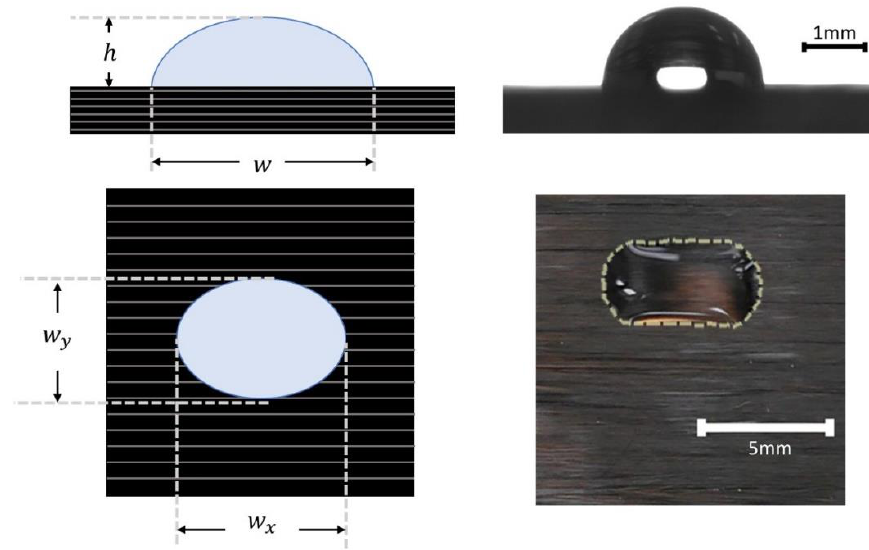
Figure 4. Diagram showing the measurements made from side and top-views of the droplet depo- sition test ( left ) and an examples of images used for such measurements ( right ), with the droplet edges outlined for clarity in the top-view.